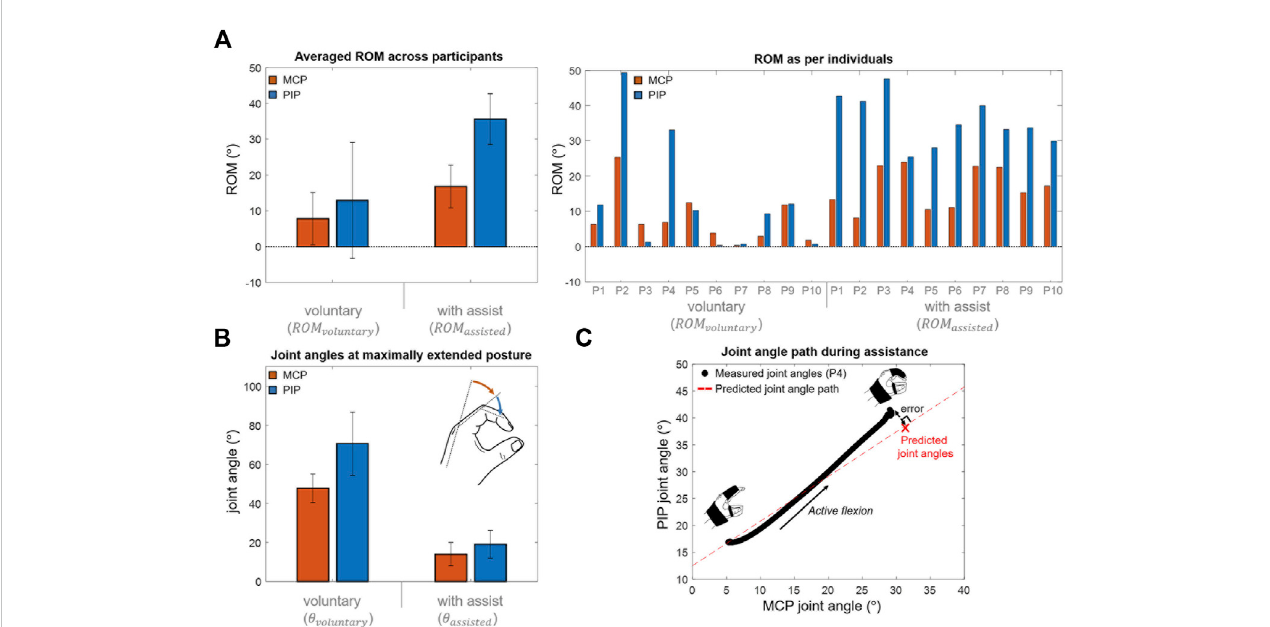
FIGURE 8 Experimental results. (A) Averaged ROM across participants during voluntary and assisted fl exions (mean difference of MCP and PIP joint ROMs = 9.0 ° , 22.8 ° ; paired t-test, p = 0.0427, 0.0033) and the ROM of individuals. (B) Averaged joint angles across participants at maximally extended posture without and with assistance (mean difference of MCP and PIP jointangles = 33.6 ° , 51.4 ° ;paired t-test, p = 2.1e-5, 3.1e-5). (C) The measured jointangle path during active fl exion. The fi nger joint angles increased in accordance with the inter-joint coordination pattern obtained from the individual hand-beam model. The “ Measured jointangles ” was obtained from 3Dtrajectories of markers attachedonthe fi nger. The “ Predicted jointangle path ” wasobtained byincreasing joint angles from the maximal assisted extension posture according to the calculated inter-joint coordination pattern.